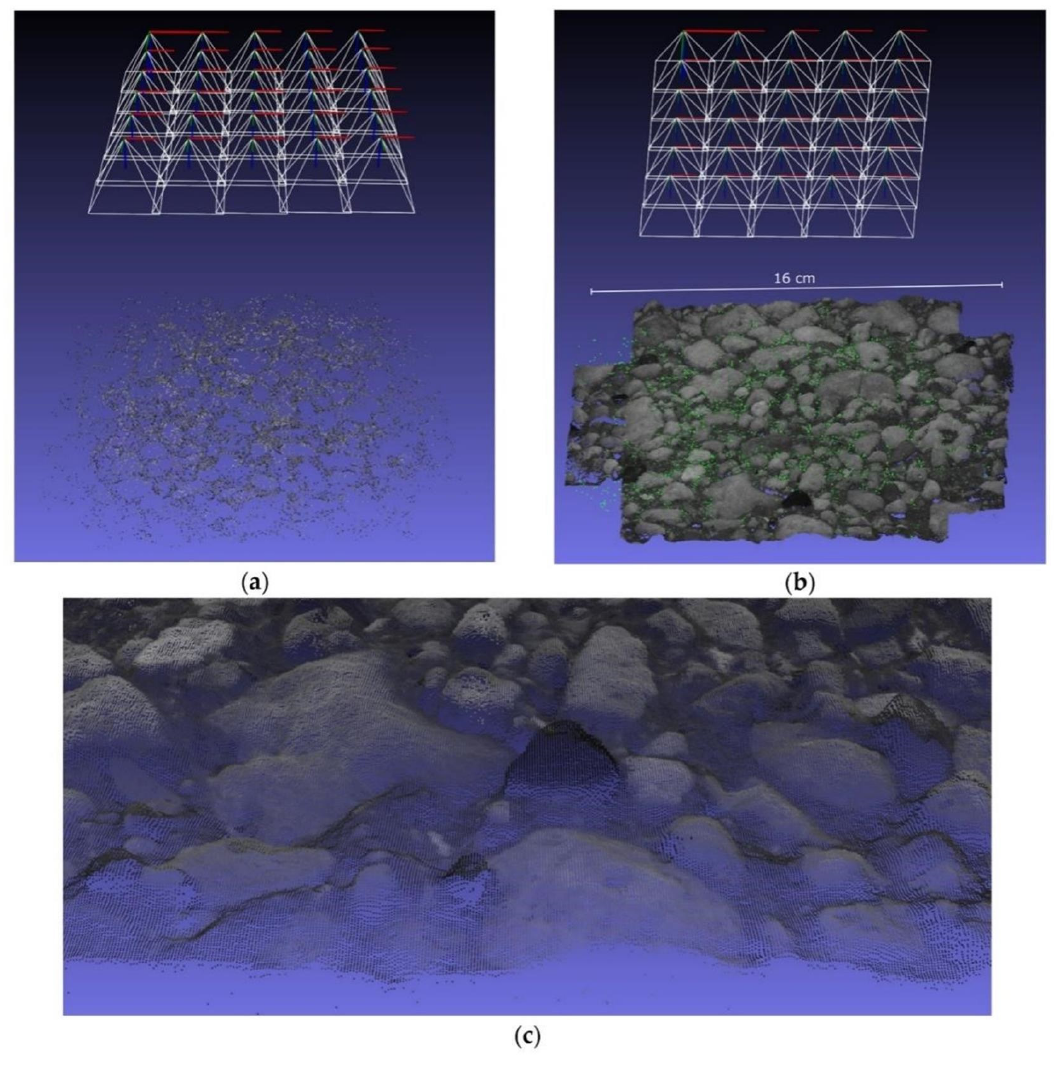
Figure 5. A 3D point cloud reconstruction of a particular concrete specimen: ( a ) Reconstructed camera poses including the sparse point cloud after SfM procedure, ( b ) generated dense point cloud after dense image matching (DIM), and ( c ) zoom-in of the dense point cloud. Reprinted from Ref. [89] with permission of Materials, 2020. Table 4. Summary of vision-based infrastructure monitoring.